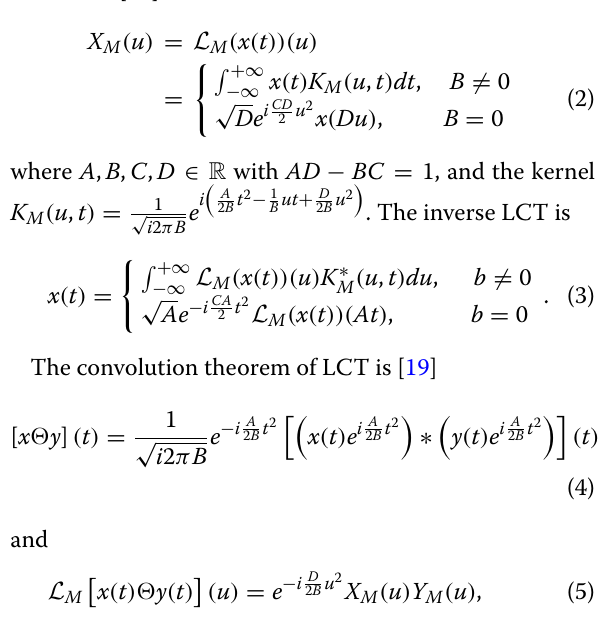
Fig. 1 The flow chart of coefficient decomposition of one layer